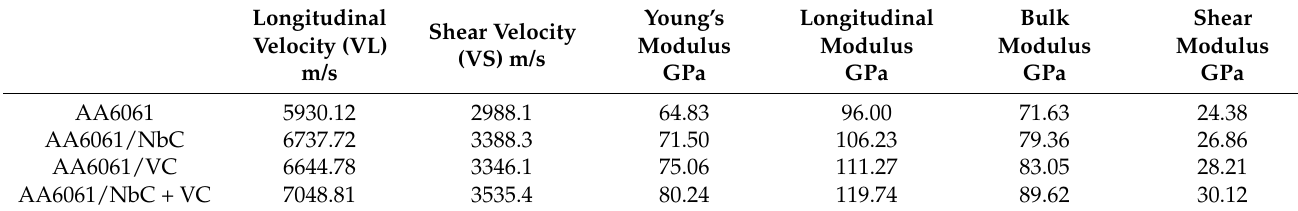
Table 3. Mechanical properties obtained from an ultrasound test.